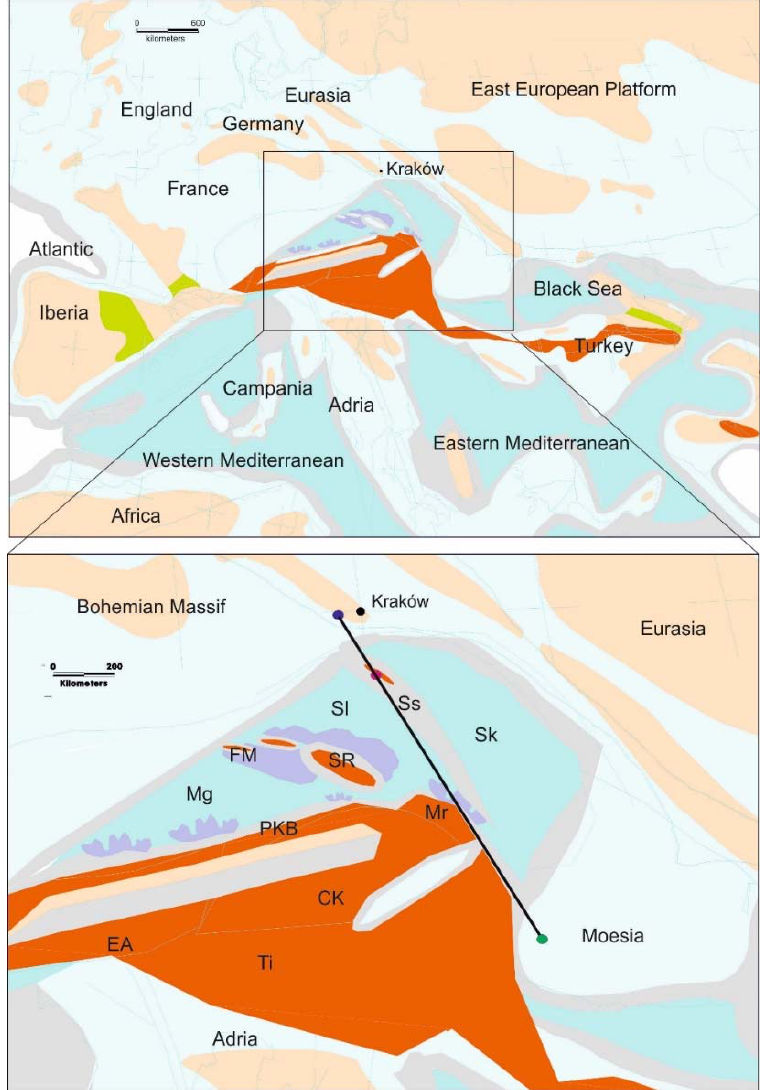
Figure 8. Paleogeography of the circum-Protocarpathian region during the Late Cretaceous– Paleocene. Legend as in Figure 7. Abbreviations: CK = Central Carpathians; EA = Eastern Alps; FM = Fore-Magura Basin; Mg = Magura Basin; Mr = Marmarosh Masssif; PKB = Pieniny Klippen Belt; Sk = Skole-Tarc ă u Basin; SR = Silesian Ridge; Ss = Subsilesian Ridge and sedimentary area; Ti = Tisza.